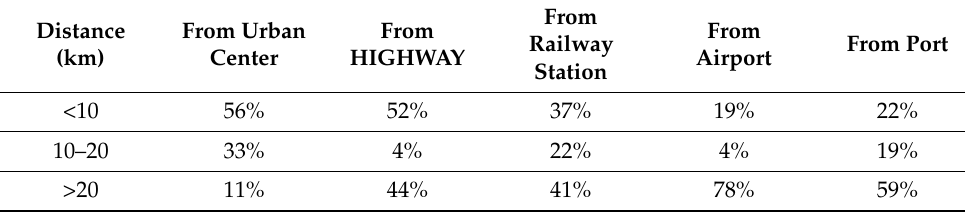
Figure 4. National-level case study of 27 business parks (OYMEDs). Source: Own elaboration by authors [77–85]. Table 3. Proximity analysis (%) of 27 organized receptors in Greece.